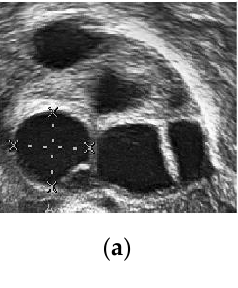
Figure 13. Comparison of different segmentation methods. ( a ) Original ultrasound image; ( b ) manual segmentation; ( c ) classical Chan–Vese method; and ( d ) Otsu thresholding and the Chan–Vese method.